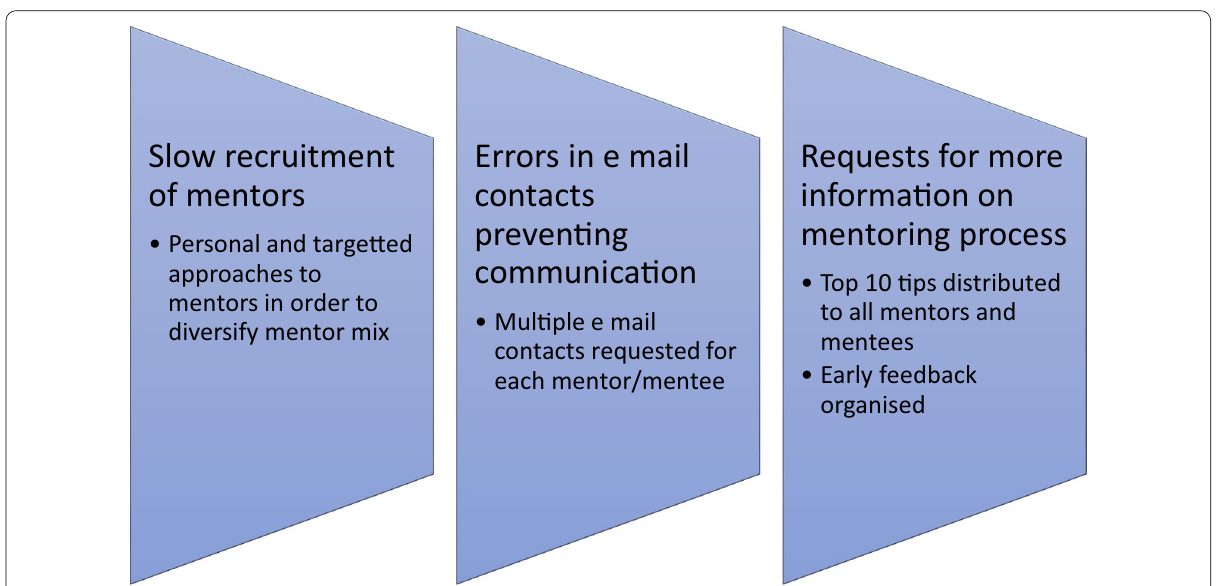
Fig. 2 Iterative modifications and interventions